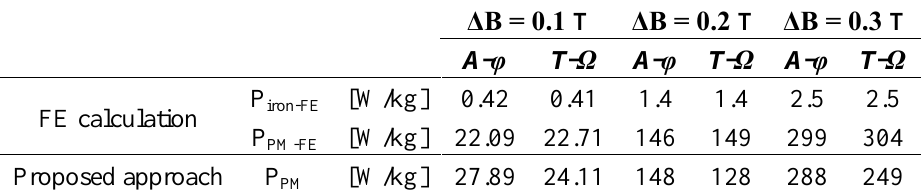
Table 3. Eddy current losses in the permanent magnet at 400